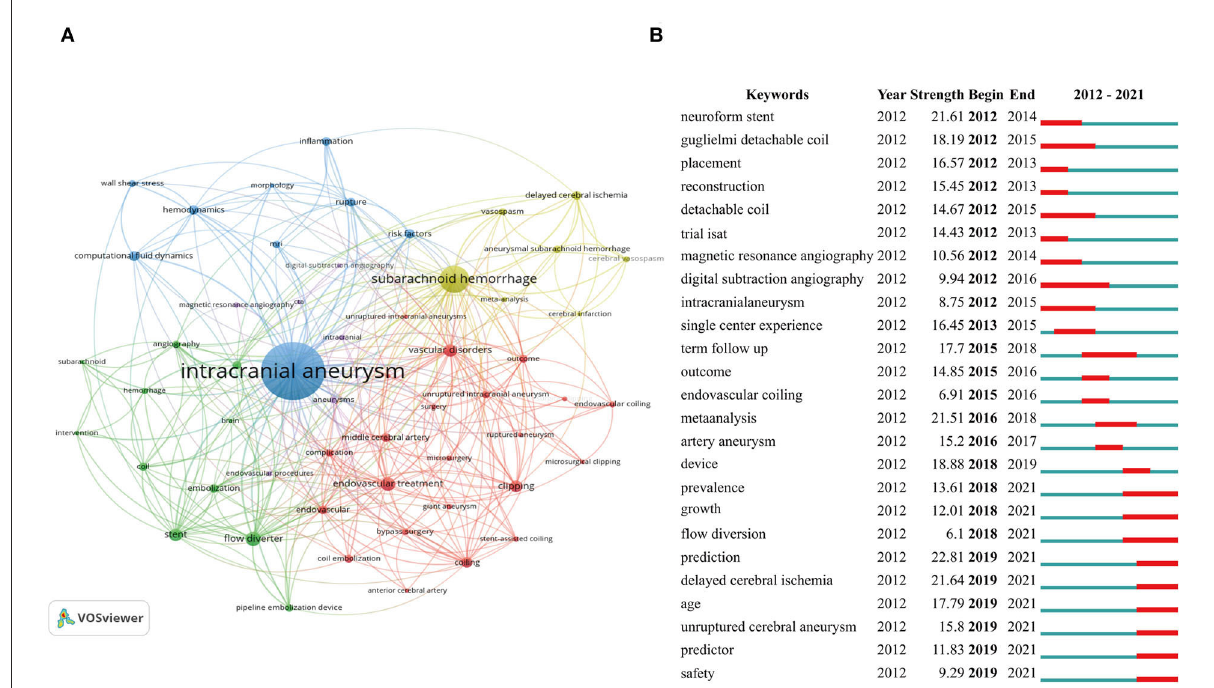
FIGURE6 Analysis of keywords related to IA studies from 2012 to 2021. (A) The keyword co-occurrence network of IA studies in the recent 10 years. The keywords clustered into five groups according to their color. Large nodes represent keywords with high frequency; (B) The top 25 keywords with the strongest citation bursts on IA studies from 2012 to 2021 were displayed by CiteSpace. The red segment on the blue line denotes the burst duration.